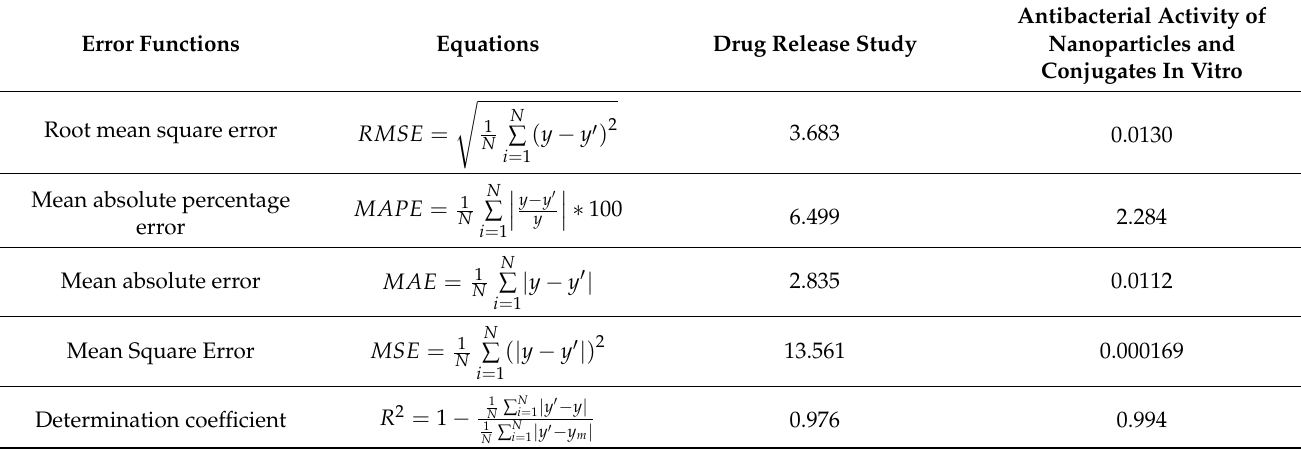
Figure 8. The release of the contents of bacterial cells that absorb at 260 nm from S. aureus under treatment of bacterial suspension with an appropriate solution. Table 10. Error functions with their equations.